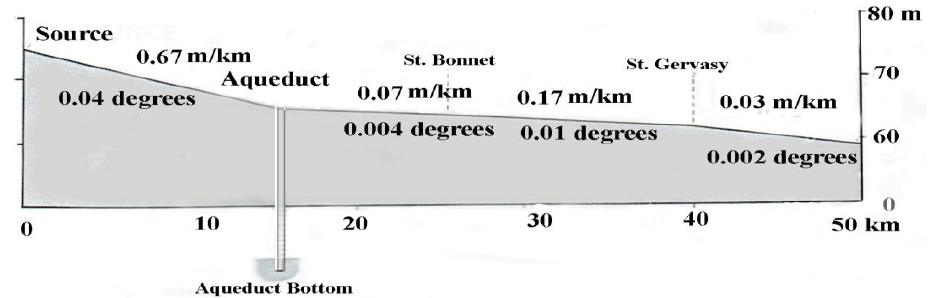
Figure 38. Aqueduct slope measurements from the Uzes spring source to the castellum. Figure derived from [30].